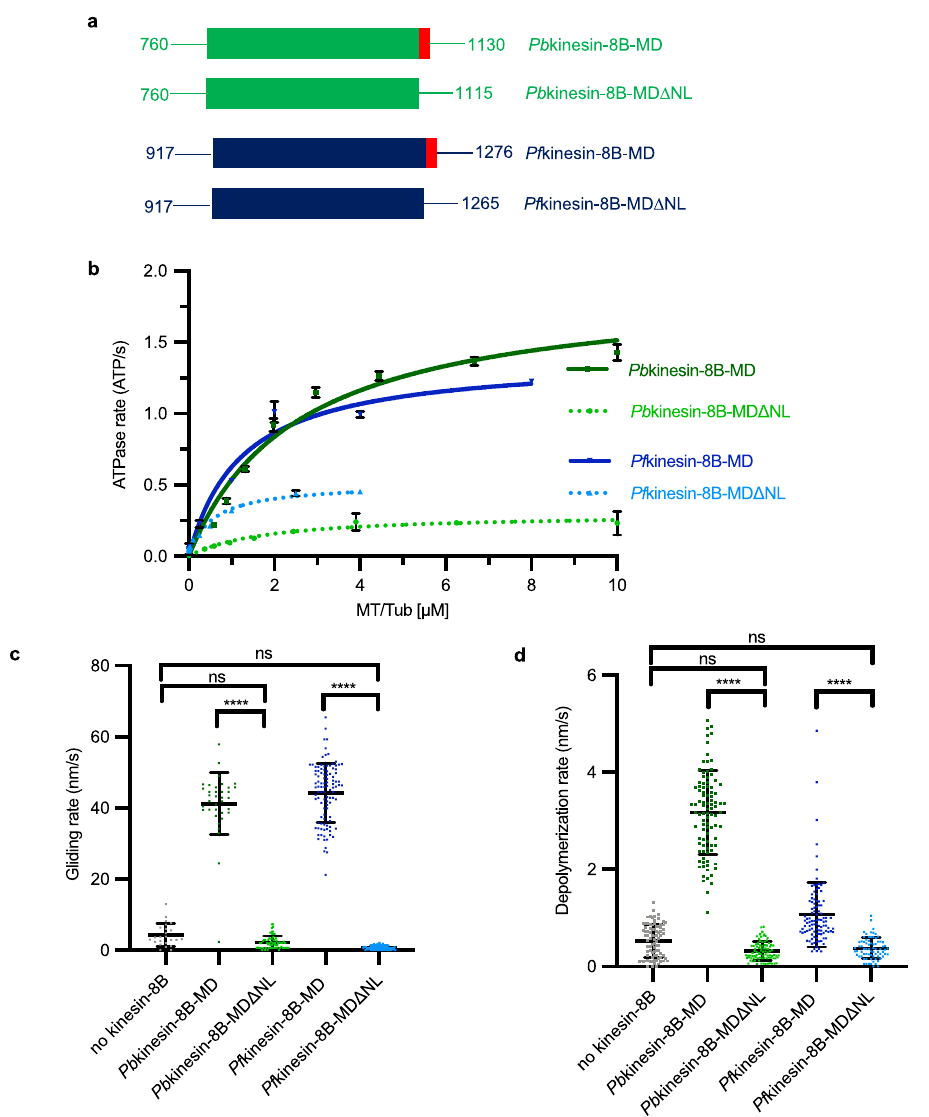
Fig. 5 | Plasmodium kinesin-8B neck linker is required for both motility and depolymeraseactivities.a SchematicofMDandMD Δ NLconstructsof Pb kinesin- 8B and Pf kinesin-8B. Motor domains are coloured in green and blue, respectively; necklinkersequencesarecolouredinred. b Kinesin-8B-MD Δ NLconstructsexhibit reduced MT-stimulated ATPase activity compared to kinesin-8B-MD ( Pb :GMPCPP- MT, Pf :paclitaxel-stabilised MT). Data ( n =3 for each point) was fi tted using Michaelis-Menten equation (mean±SD), from which the Kcat and K M were calcu- lated in Prism9. c Kinesin-8B-MD Δ NL construct exhibit no signi fi cant gliding activity. Paclitaxel-stabilised MTs were used. Error bars represent the mean±SD and individualmeasurements arealso plottedwithcoloured points.Ordinary one- wayANOVAwasperformedinPrism.Signi fi cancevaluesaredisplayedasasterisks, **** p -values<0.0001;nsnotsigni fi cant, p =0.5803(no-kinesin-8Bvs. Pb kinesin-8B- MD Δ NL) and 0.0831 (no-kinesin-8B vs. Pf kinesin-8B-MD Δ NL). N Pb kinesin-8B-MD =36 MTs. N Pb kinesin-8B-MD Δ NL =67 MTs. N Pf kinesin-8B-MD =104 MTs. N Pf kinesin-8B-MD Δ NL =77